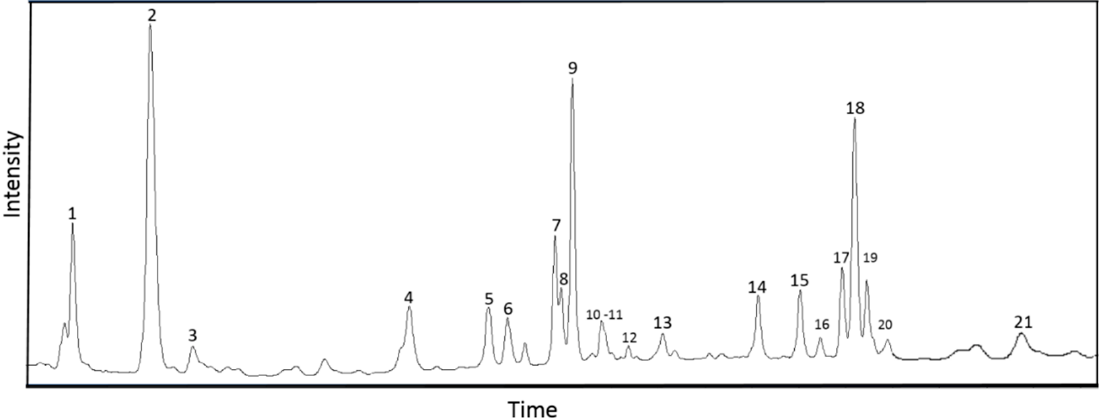
Figure 1. HPLC–MS/MS chromatogram of Aloe vera extract.